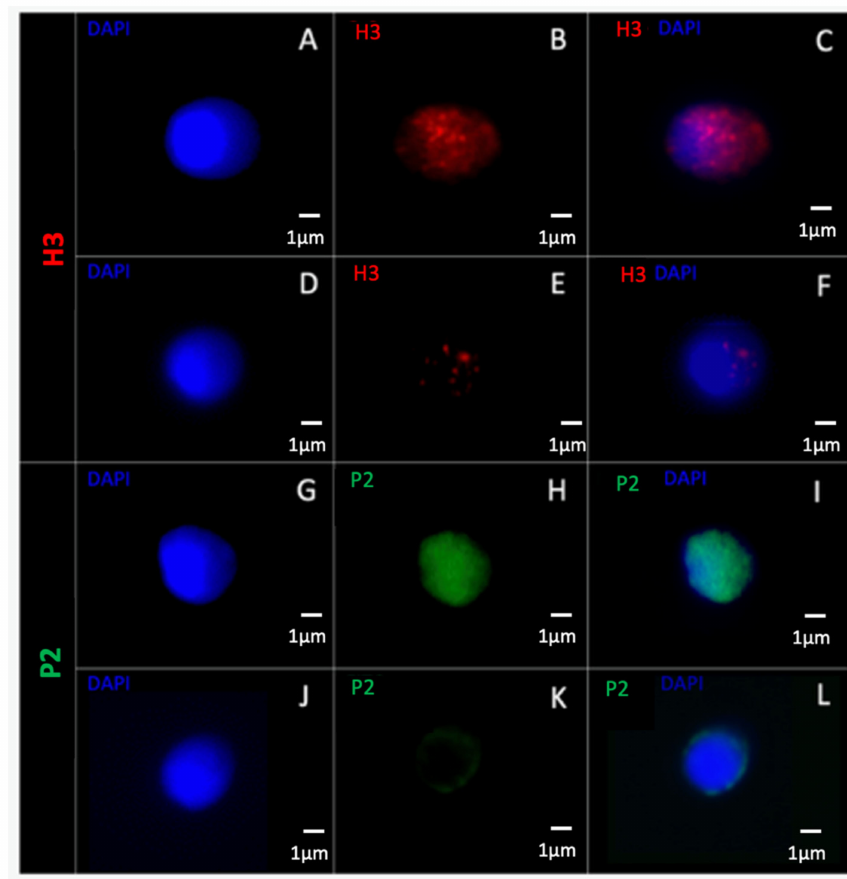
Figure 3. Spermatozoa observed under a two-dimensional fluorescence microscope. A spermatozoon observed with ( A ) DAPI labelling (blue), ( B ) H3-Cy3 positive labelling (red), and ( C ) DAPI/H3-Cy3 merge. Another spermatozoon observed with ( D ) DAPI labelling, ( E ) H3-Cy3 negative labelling, and ( F ) DAPI/H3-Cy3 merge. A spermatozoon observed with ( G ) DAPI labelling, ( H ) P2-FITC positive labelling, and ( I ) DAPI/P2-FITC merge. Another spermatozoon observed with ( J ) DAPI labelling, ( K ) P2-FITC negative labelling, and ( L ) DAPI/P2-FITC merge. H3: histone 3; Cy3: cyanin3; P2: protamine 2; FITC: fluorescein isothiocyanate; DAPI: 4 (cid:48)